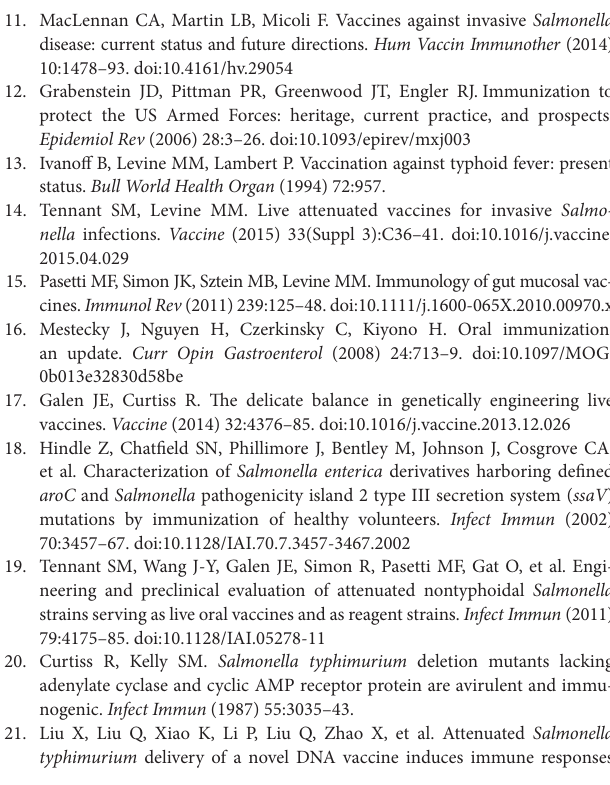
FigUre s1 | The O-antigen gene clusters of B1, D1, C1, and C2 serogroups. The O-antigen gene clusters of Salmonella Typhimurium (B1, O4), S. Enteritidis (D1, O9), S. Choleraesuis (C1, O7), and S. Newport (C2, O8) are shown and the immunodominant O-serotype factor was labeled in front of the gene cluster. Genes were color coded by biosynthesis pathways. Arrows represented the location and orientation of the genes. Diagrams are drawn to scale. FigUre s2 | The chemical structures of B1, D1, C1, and C2 serogroup O-units. The chemical structures illustrating the sugar components and glycosidic linkages within the O-units of Salmonella Typhimurium (a) , S. Choleraesuis (B) , S. Enteritidis (c) , and S. Newport (D) . The immunodominant O-serotype factor was labeled under the structures. Sugar abbreviations: Abe, abequose; Tyv, tyvelose; l -Rha, l -rhamnose; d -Man, d -mannose; d -Gal, d -galactose; d -GlcNAc, d -acetylgalactosamine.